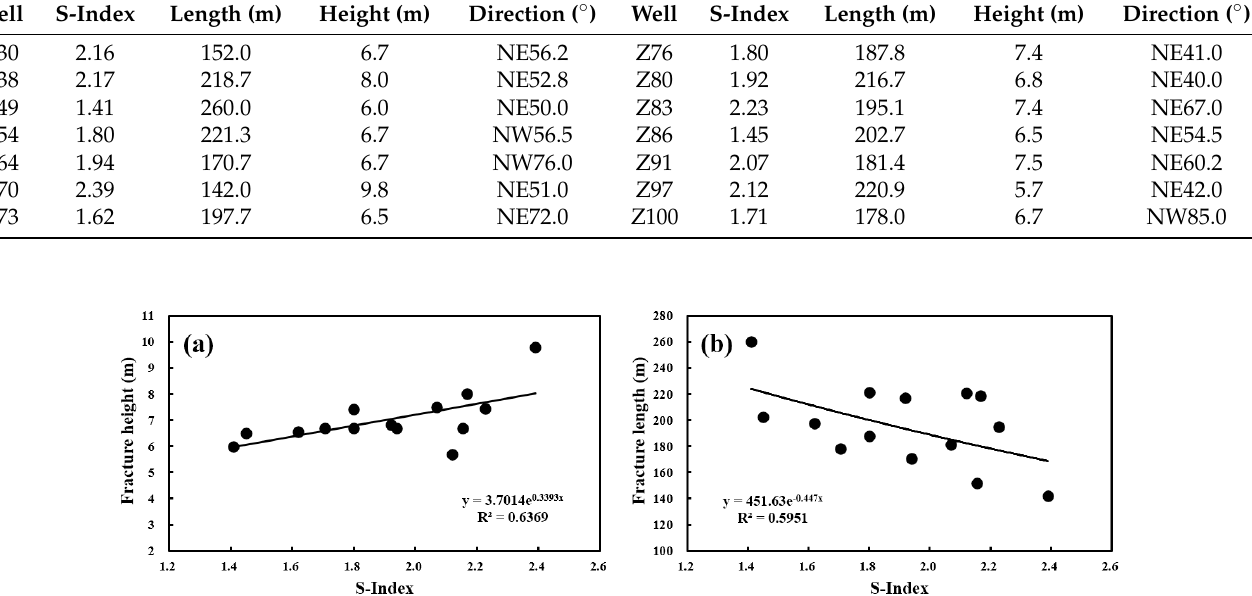
Table 6. Hydraulic fractures distribution of some wells in study area.